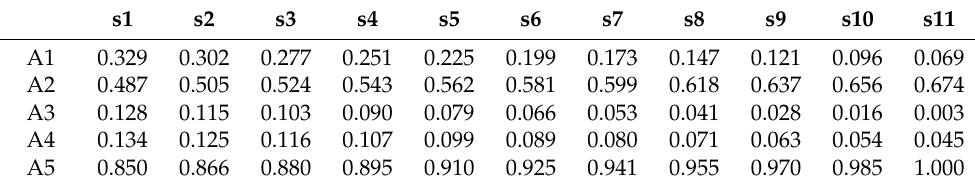
Table 10. New criteria weights for economic criteria.